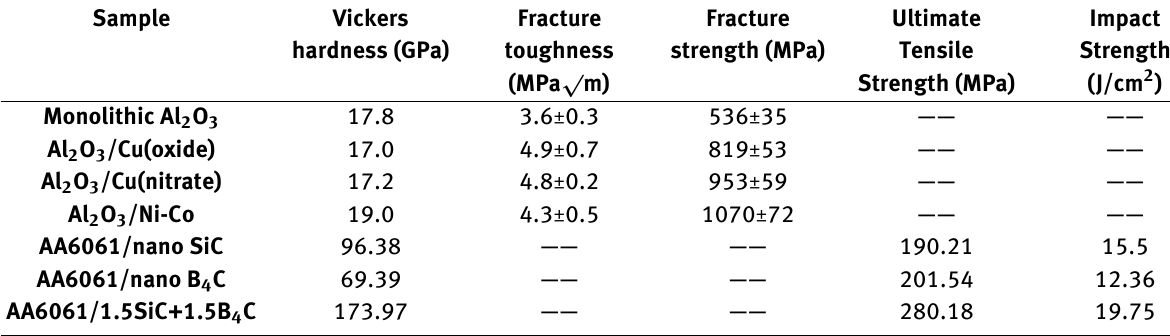
Table 3: Mechanical properties of metal nanomaterials [56, 57] Sample